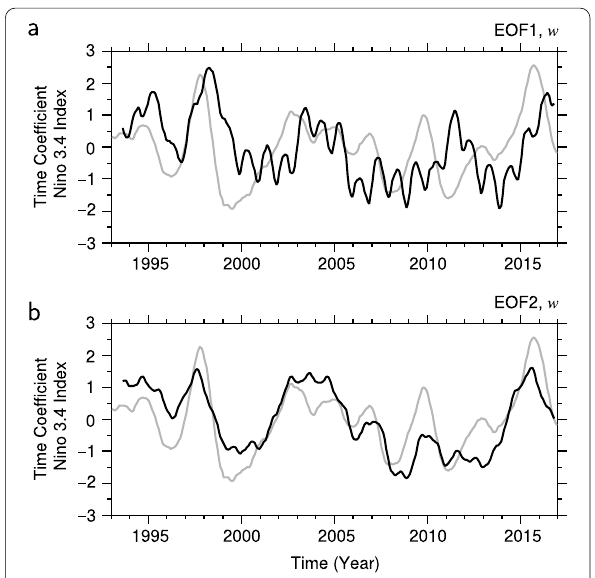
Fig. 12 Time coefficients of the a first and b second EOF modes of vertical velocity w (black lines) and Niño 3.4 index (gray lines). For comparison, Niño 3.4 index was smoothed by a 15-month running mean filter. All the time series were normalized by their standard deviations